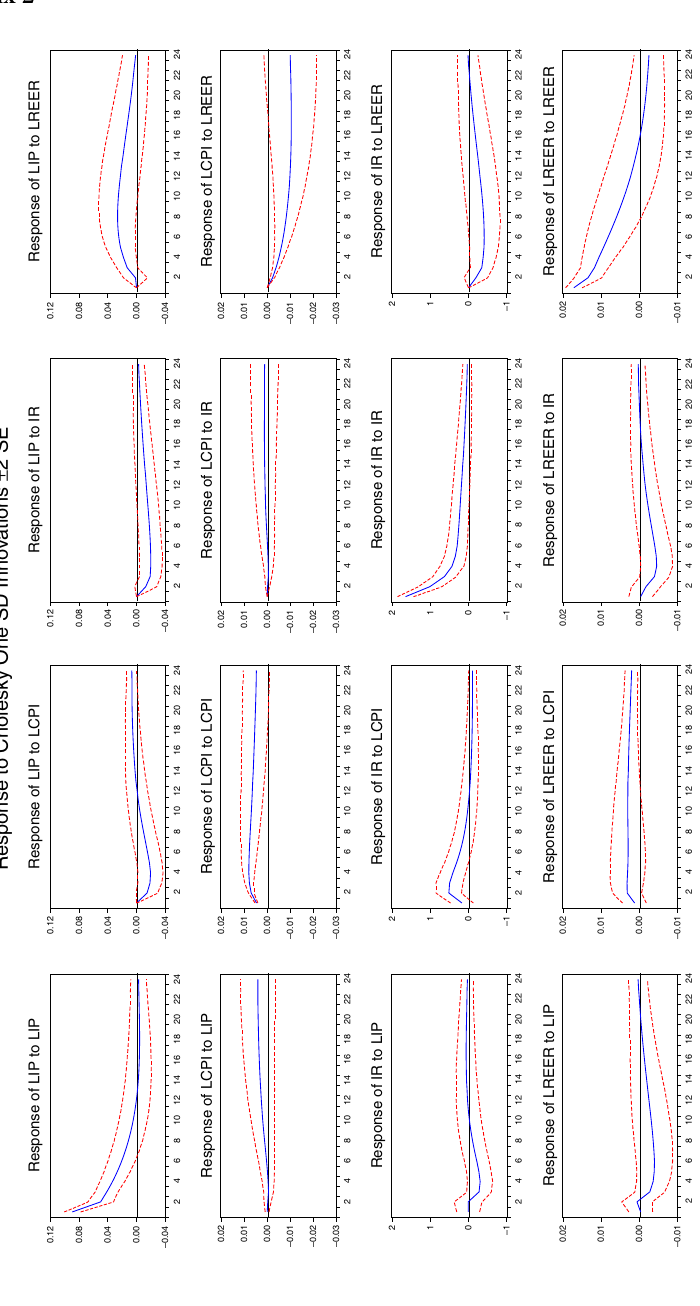
Figure A2. Impulse responses of Model 2 (recursive